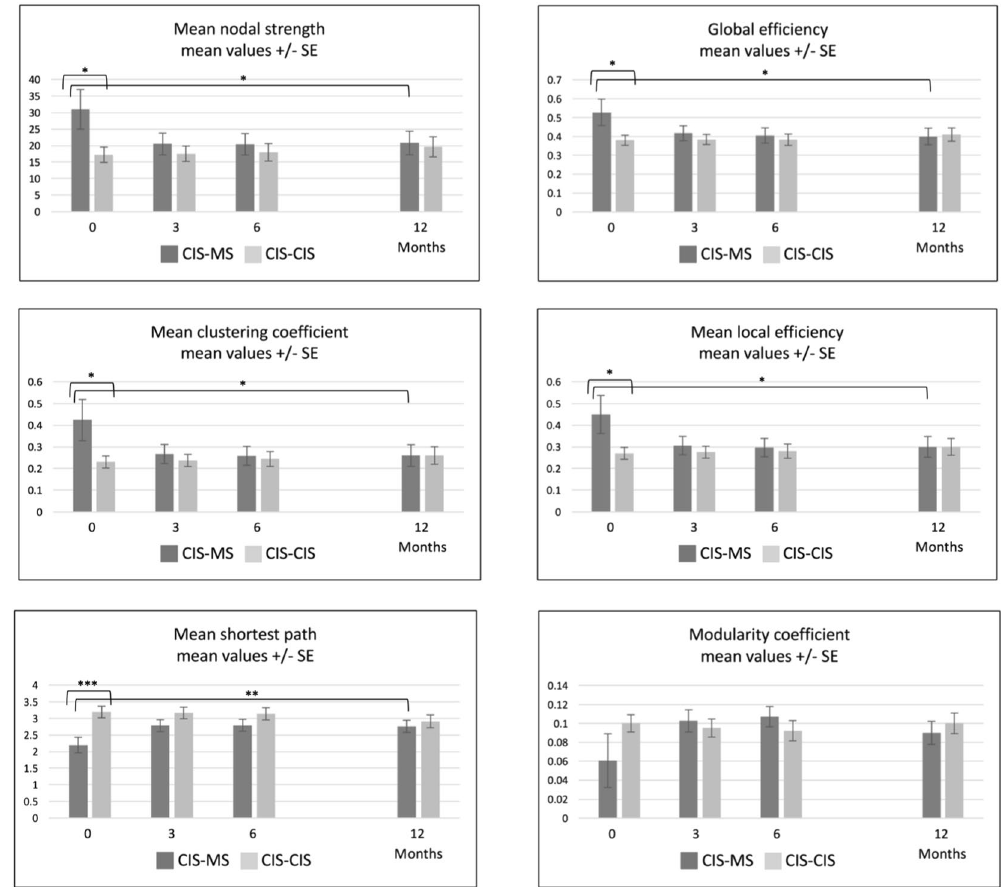
Figure 2. Network metrics over time in MS converters and non-MS converters. This figure shows the evolution of network metrics over time for MS converters and non-MS converters, with the bootstrap standard errors. * p < 0.05; ** p < 0.01; *** p < 0.001. Please look at Table 3 for more